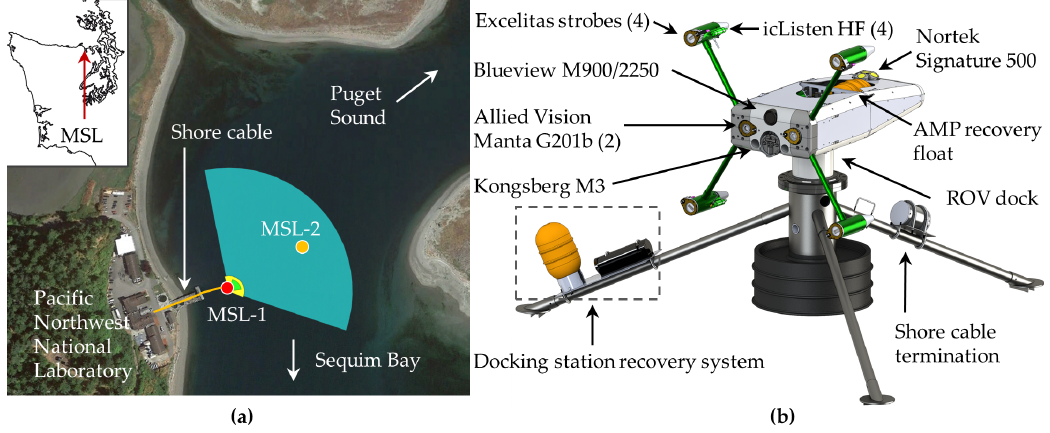
Figure 4. MSL-1 AMP deployment showing ( a ) site layout with MSL-2 location noted and ( b ) AMP and docking station lander. The AMP control computer was located on